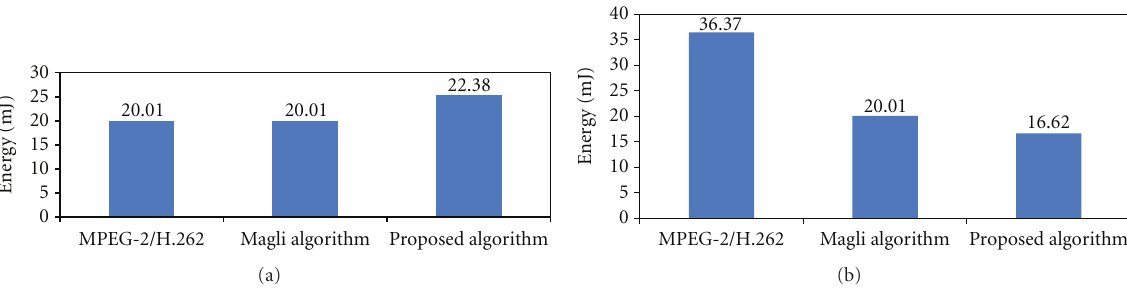
Figure 14: Comparing encoding energy consumption among algorithms for Carphone video with: (a) the intraframe and (b) the interframe (P-frame).